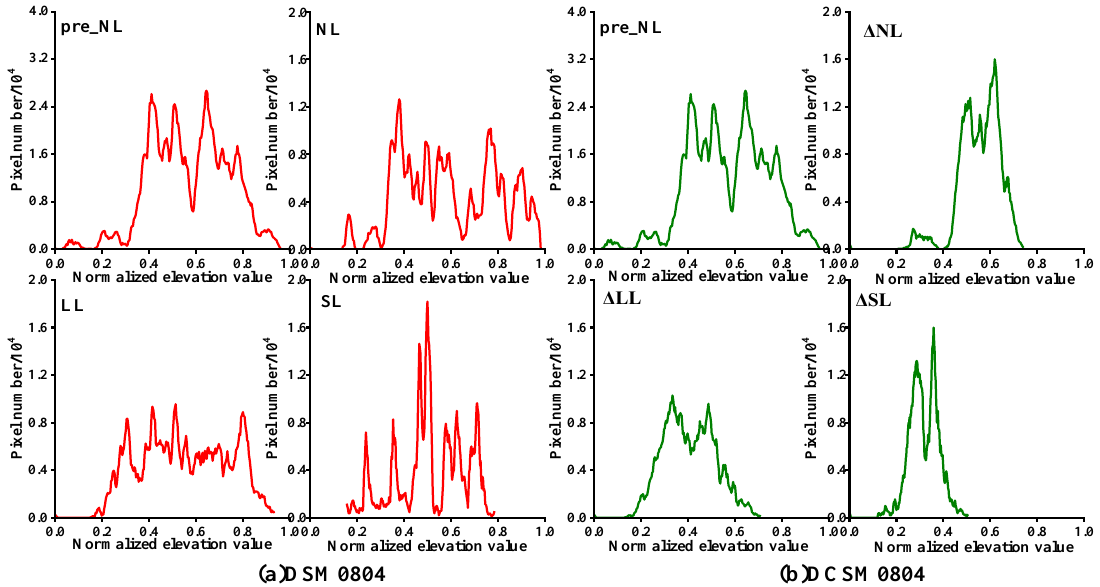
Figure 8. Histogram of digital surface model elevation for plots with various degrees of lodging. The vertical axis gives the number of pixels at each height on the horizontal axis. Panel ( a ) shows the results for the NL, LL, and SL, and panel ( b ) shows the results for the difference between the two DSMs (denoted ΔNL, ΔLL, and Δ SL).